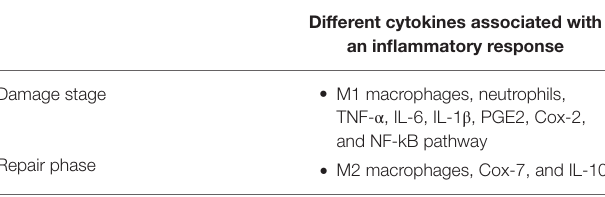
TABLE 2 | LLLT downregulates diverse inflammatory cytokines. Different cytokines associated with an inflammatory